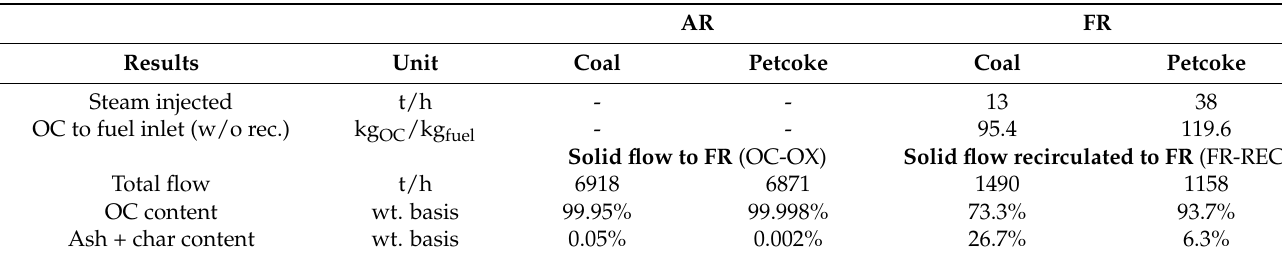
Table 8. Resulting processes